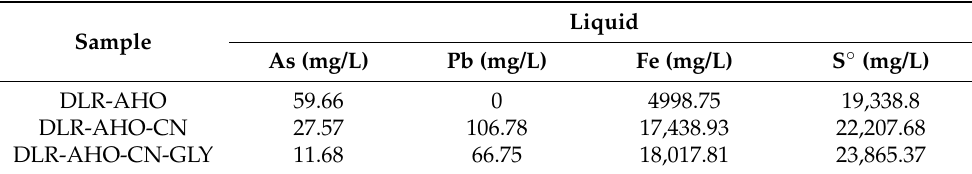
Table 6. Concentration of As, Pb, Fe, and S of the liquid samples obtained during the DLR-AHO pretreatment and the conventional and glycine-assisted cyanidation.